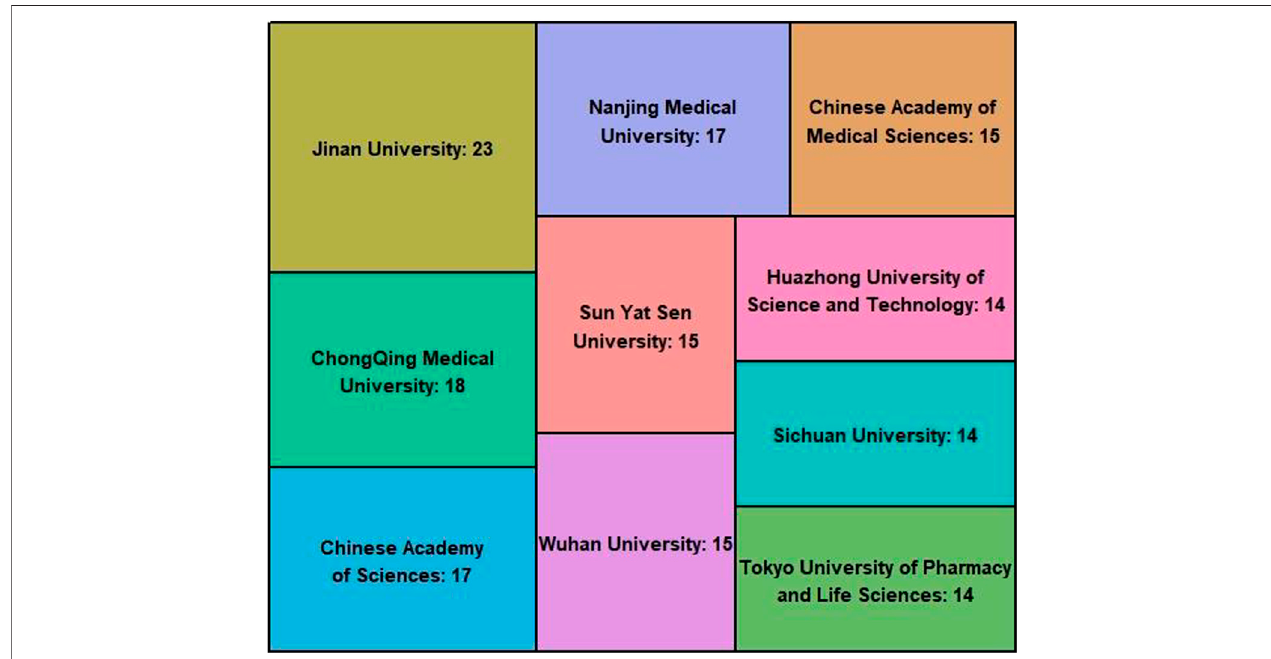
FIGURE 9 | The top 10 most productive institutions. The data in the fi gure refer to the publication of the speci fi c institution. The size of each board area is proportional to the number of articles.